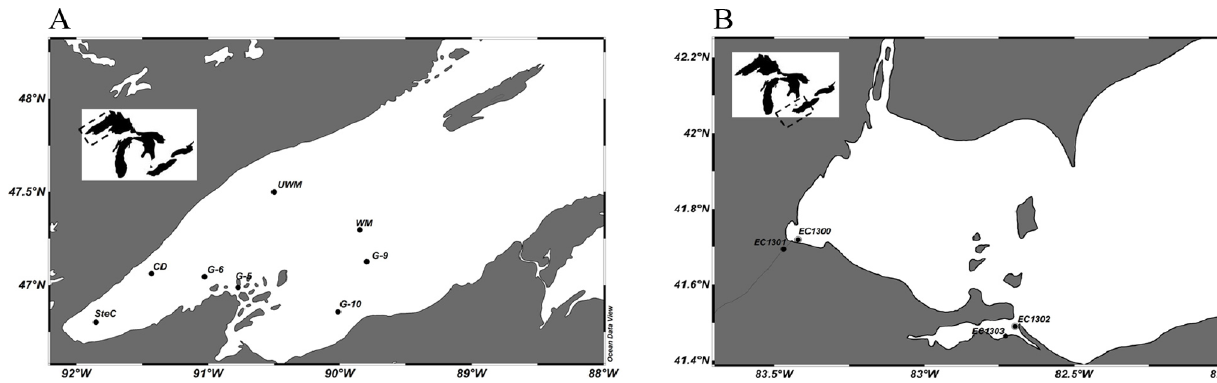
Figure 1. Sampling sites for Lake Superior (A) and Lake Erie (B) sediments.